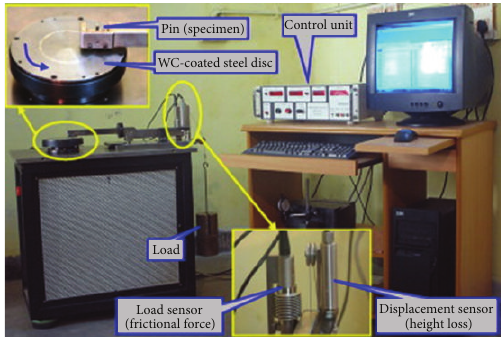
Figure 3: Pin-on-disc wear testing rig.